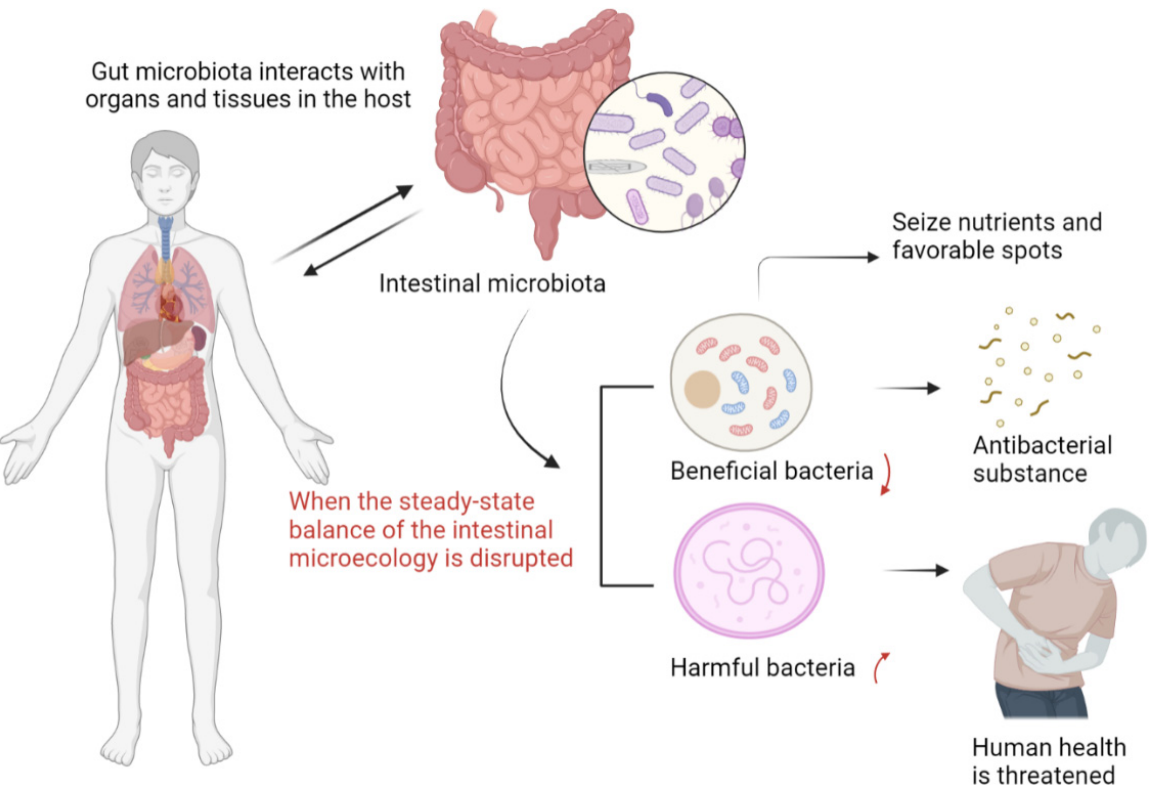
Figure 3. The direct interaction between the intestinal flora and the human body.